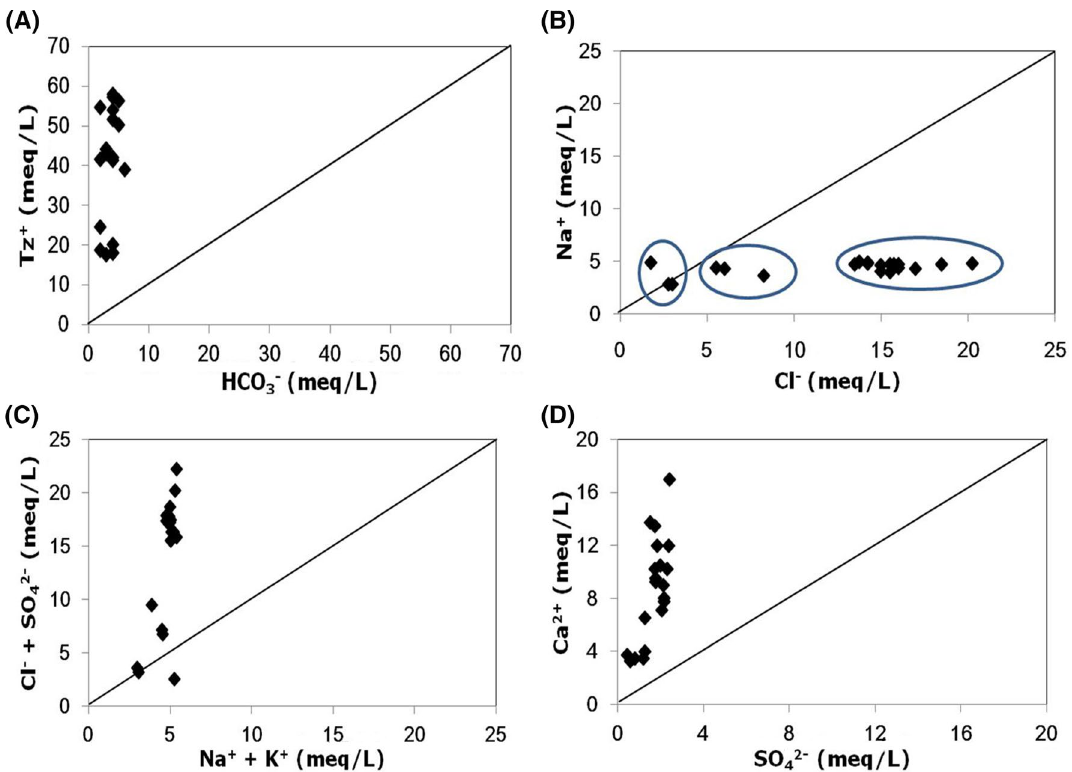
Fig. 4 Scatter plots for hydrogeochemical evolutionary processes, a scatter plot between HCO 3− and Tz + , b scatter plot between Cl − and Na + , c scatter plot between Na + + K + and Cl − + SO 42− and d scatter plot between SO 42− and Ca